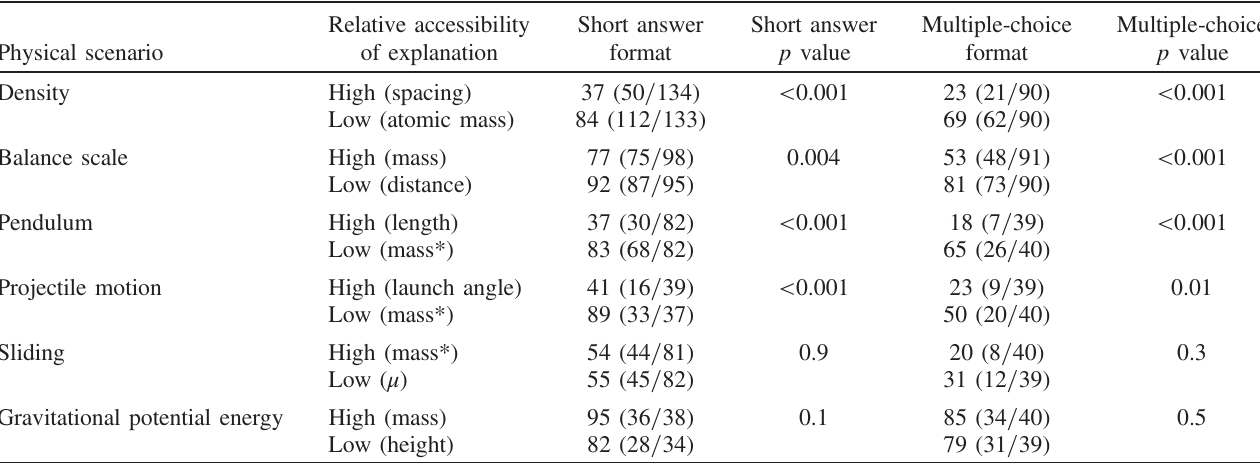
TABLE VI. Experiment 2 percentages (and ratios) of participants who indicated alternative explanations may exist when presented with an explanatory factor with the indicated accessibility. The p values are not Bonferroni adjusted. Note that the factors with asterisks are not physically